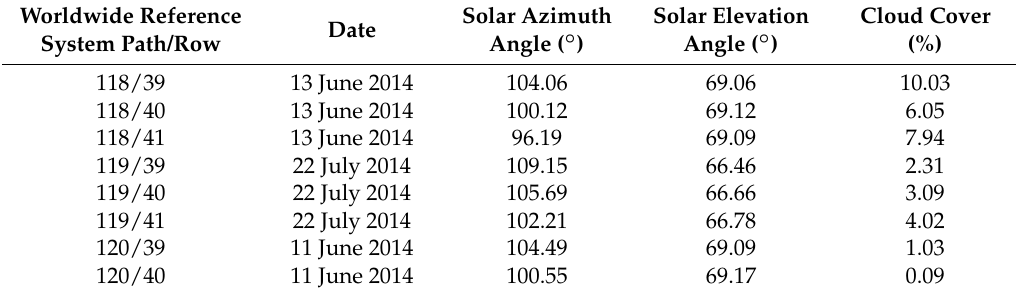
Table 1. Details of the Landsat 8 OLI